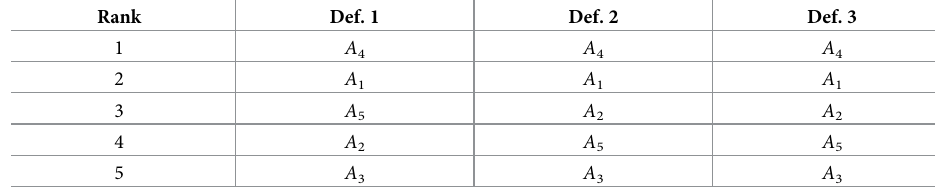
Table 6. Alternatives’ rankings with respect to Definitions 1–3.